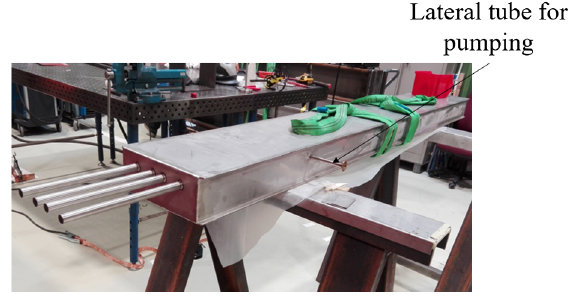
FIG. 4. The HIP capsule containing the CuCr1Zr and tubes assembly, PT and He leak tested with the lateral tube for pumping.